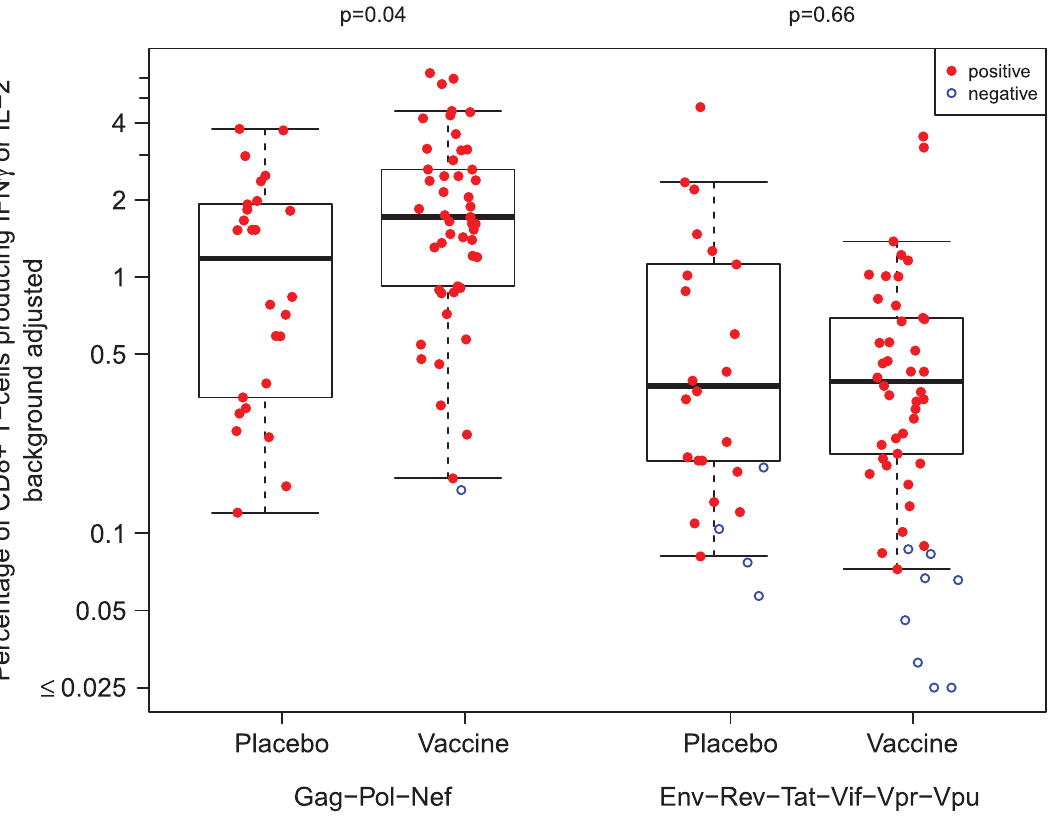
Figure 1. Post-Infection Magnitude of CD8 + T-Cell Response. Magnitude of the post-infection CD8 + T-cell response measured by ICS, as quantified by the percentage of CD8 + T-cells producing IFN or IL-2 when stimulated with the vaccine-insert-matched peptide pools (Gag, Pol, and Nef) and other non-vaccine-insert peptide pools, for vaccine and placebo groups. Positive responses are indicated using closed red circles and negative responses using open blue circles. The p-values refer to tests comparing response magnitudes between the vaccine and placebo positive responders.